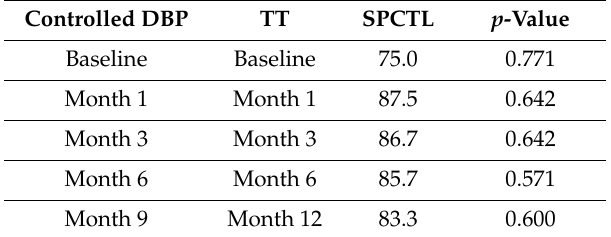
Table 3. Proportion of participants meeting the 2017 ACC / AHA Revised Guidelines for Controlled DBP ( < 80 mmHg). Controlled DBP TT SPCTL p -Value Baseline Baseline 75.0 0.771 Month 1 Month 1 87.5 0.642 Month 3 Month 3 86.7 0.642 Month 6 Month 6 85.7 0.571 Month 9 Month 12 83.3